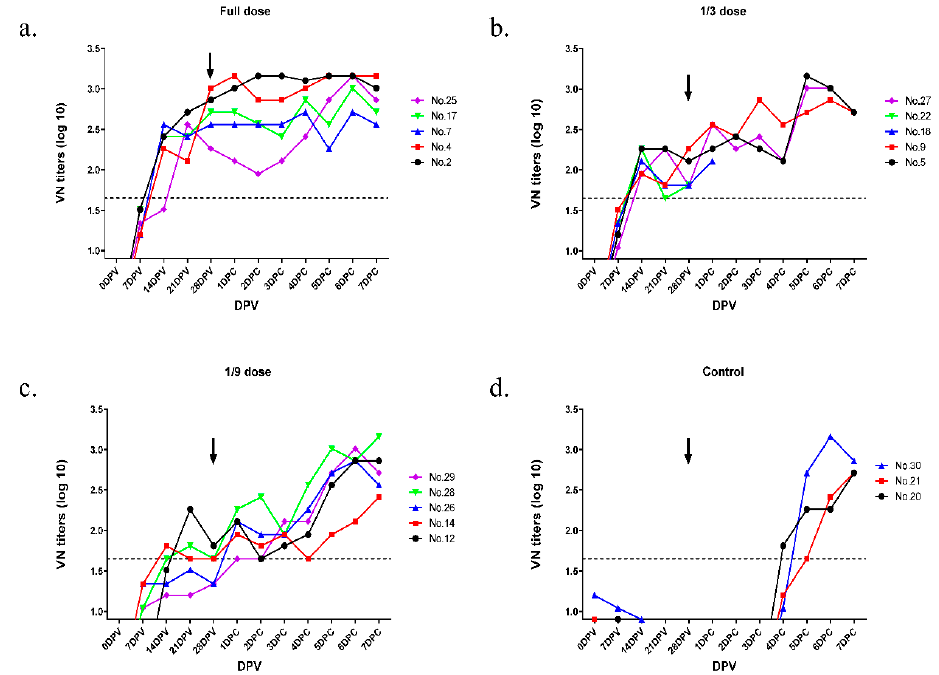
Figure 6. Virus neutralizing antibody titers against serotype A homologous virus in pigs after immunization with the bivalent vaccine. Pigs ( n = 18) were vaccinated with full dose ( a ), 1/3 dose ( b ), 1/9 dose ( c ), control ( d ) and blood samples were collected and challenged with A/Yeoncheon/SKR/2017 at 28 dpv with 1 × 10 5 TCID 50 /0.1 mL in the bulb of the heel. Moreover, a virus neutralization test with A/Yeoncheon/SKR/2017 was performed as described in Figure 4. Black arrows indicate the challenge time at 28 dpv. Table 2. Summary of the immune response and protective effect for A/Yeoncheon/SKR/2017 after immunization of pigs with the bivalent vaccine. Figure 7. Clinical scores and virus shedding in pigs immunized with a bivalent vaccine after the A/Yeoncheon/SKR/2017 challenge. Oral swab and blood samples were collected daily from the pigs ( n = 18) that were vaccinated with the bivalent vaccine in the full dose ( a ), 1/3 dose ( b ), 1/9 dose ( c ), and control ( d – f ) groups until 7 days post-challenge. Clinical symptoms were examined daily after the virus challenge. The foot-and-mouth disease virus (FMDV) RNA was identified by the extraction of viral RNA from oral swab samples and quantitative real-time polymerase chain reaction (RT-PCR).